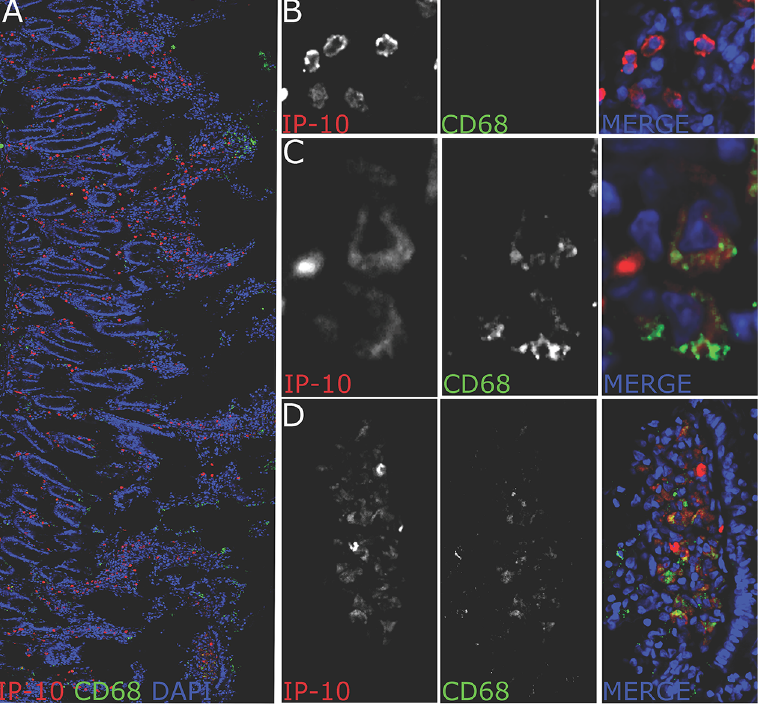
Fig 8. IP-10 positive cells in jejunum of chronically SIVmac-infected macaques. (a) confocal image of a jejunum section stained for CD68 (green), IP-10 (red) and total nucleus (blue). The picture represents the distribution of IP-10+ cells in jejunum of chronically infected macaques (240 dpi) (representative picture for one animal out of 3 animals studied). IP-10+ cells were found in the lamina propria around and in the villi as well as at the top of the villi. Most IP-10+ cells were CD68 negative. A fraction of CD68+ cells produced IP-10. Cells were often organized in clusters. (B) Magnification showing IP-10+ cells negative for CD68 found at the bottom of the villus. The morphology evoke T cells. (C) Magnification showing IP-10+ positive for CD68+. (D) Magnification showing IP-10+ cells organized in a cluster. Many IP-10+ cells in these clusters were CD68+. Pictures were obtained using a leica SP8 confocal microscope. All pictures were analyzed with ImageJ